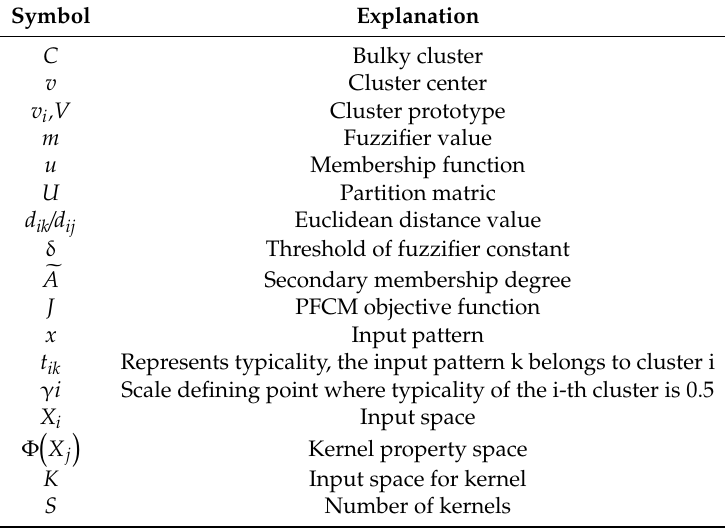
Table 1. Explanation of